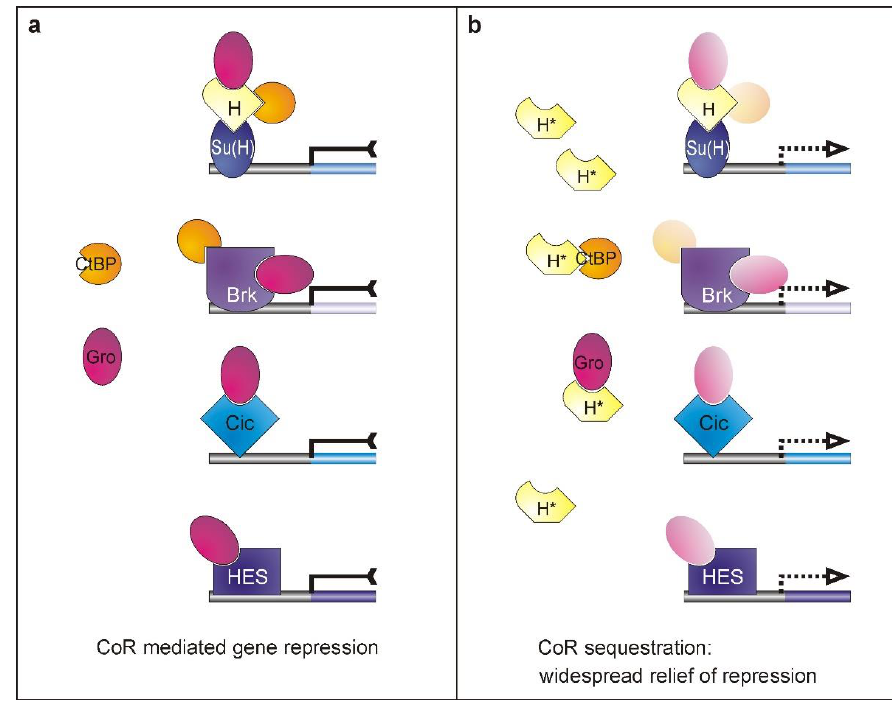
Figure 6. Model explaining the ectopic veinlet phenotype. ( a ) General co-repressors Gro and CtBP